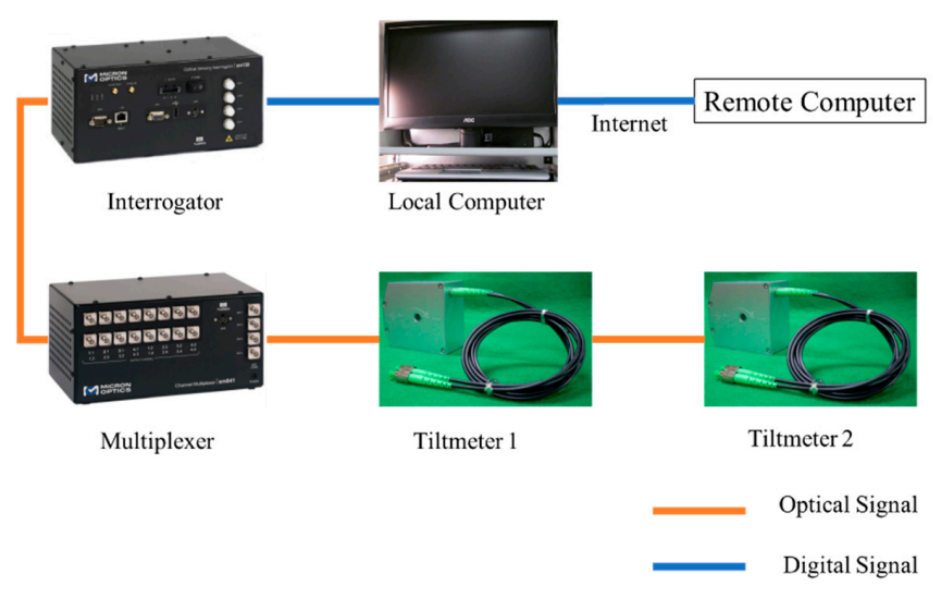
Figure 8. Configuration of the fiber Bragg grating (FBG) inclinometer monitoring system [147] .